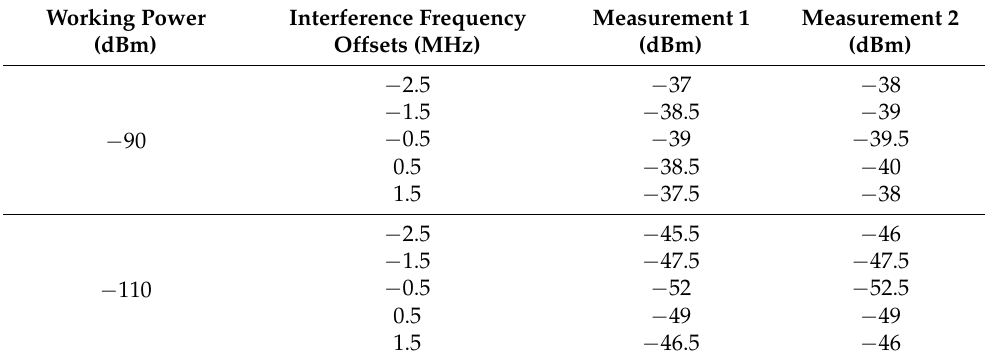
Table 4. Measurement values of critical interference power when the sensitivity criterion is